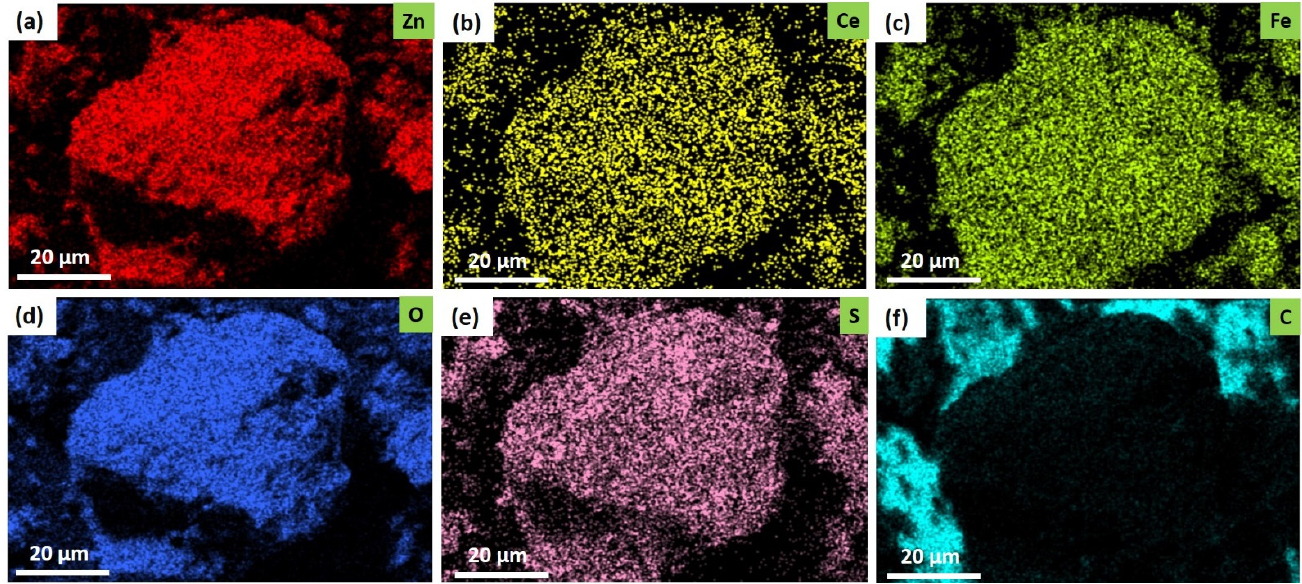
Figure 4. Elemental mapping images of ZnCe x Fe 2 − x O 4 (X = 0.08) NPs, where ( a ) for Zn atom, ( b ) for Ce atom, ( c ) for Fe atom, ( d ) for O atom, ( e ) for S atom, and ( f ) for C atom.